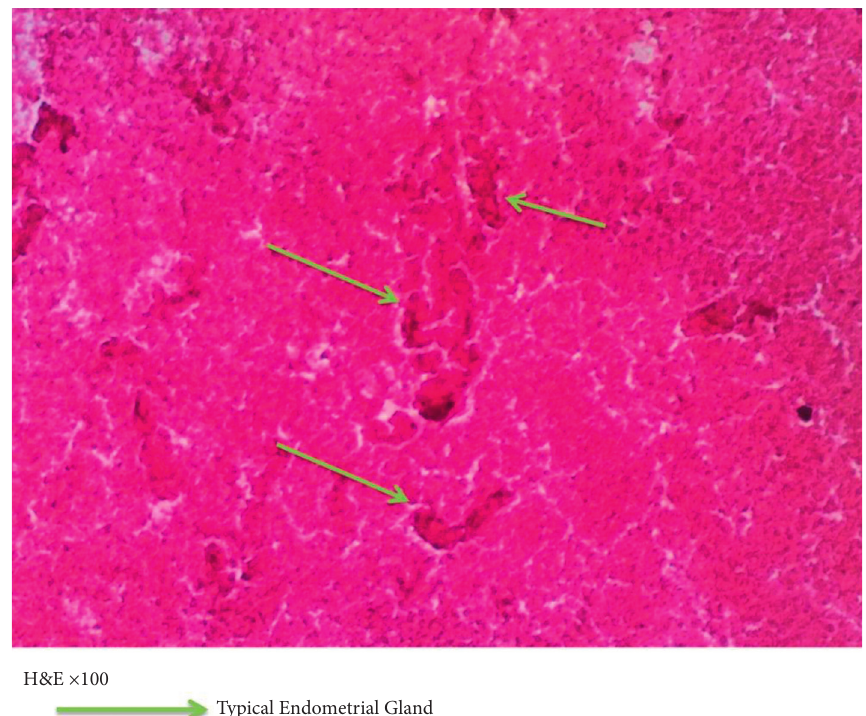
Figure 3: Hematoxylin and eosin staining of pleural fluid sample showing the presence of typical endometrial glands.